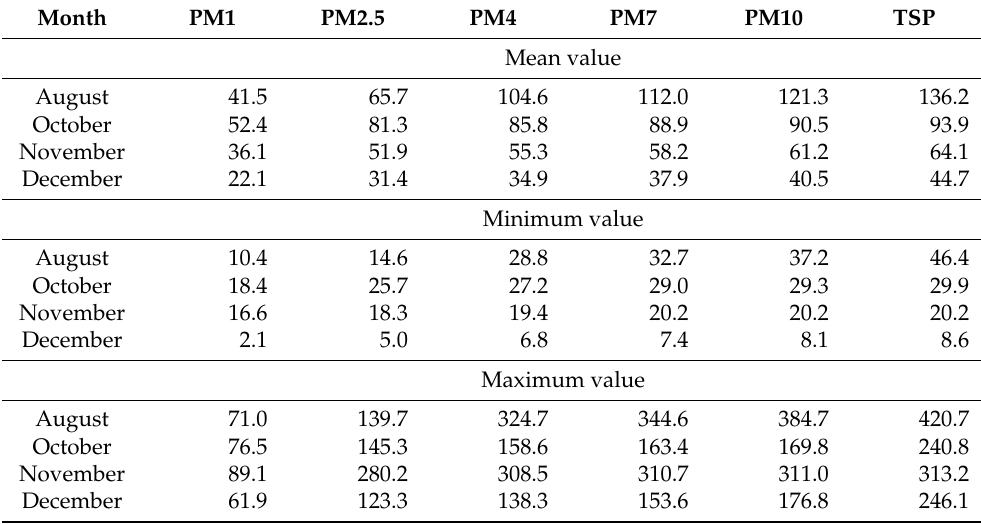
Table 2. The statistics for the mean, minimum and maximum values ( µ g/m 3 ) for the hourly concen- trations of PM fractions in the selected months in the garage of the tested fire station. Month PM1 PM2.5 PM4 PM7 PM10 TSP Mean